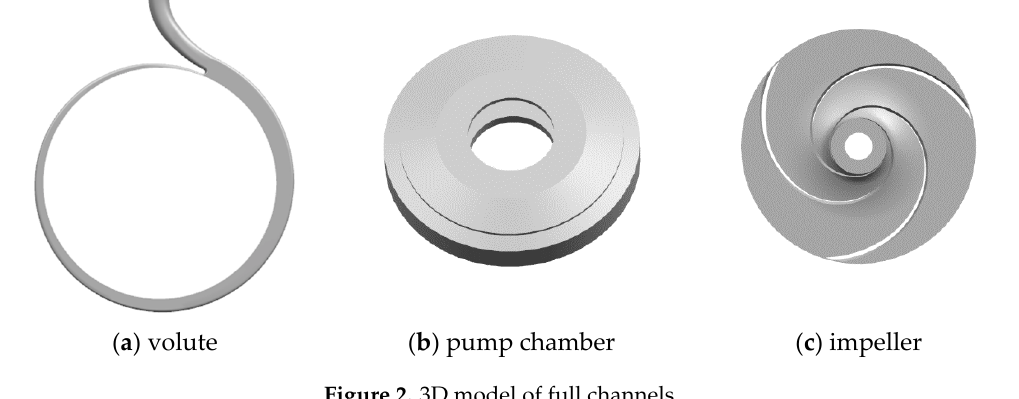
Figure 3. Assembly diagram of the calculation domain. 3.2. Grid Computational Fluid Dynamics (CFD) technology is a process of using fluid mechanics control equations to solve the pressure, velocity, and other variables of the discrete element to obtain the entire flow field. Discretization of the flow field with meshing is the basis of CFD technology. It is mainly divided into a structured grid and unstructured grid. The unstructured grid uses internal algorithms to automatically divide the grid nodes. The internal grid nodes have no adjacent elements, which are irregular connections. It has the advantage of simple generation and good adaptability to complex structures. However, there are shortcomings such as the large number of grids, the occupation of computing resources, and the difficulty of processing the boundary layers effectively [22]. In a complex rotating machine such as the centrifugal pump, typical flow separation and other phenomena could occur, which affect the accuracy of calculation results. The structural grid topologically divides the flow field [23]. All grid nodes have adjacent elements, which are lines of orthogonal processing points. It has the advantages of simple data structure and easy boundary fitting. It can provide fewer grids, higher calculation